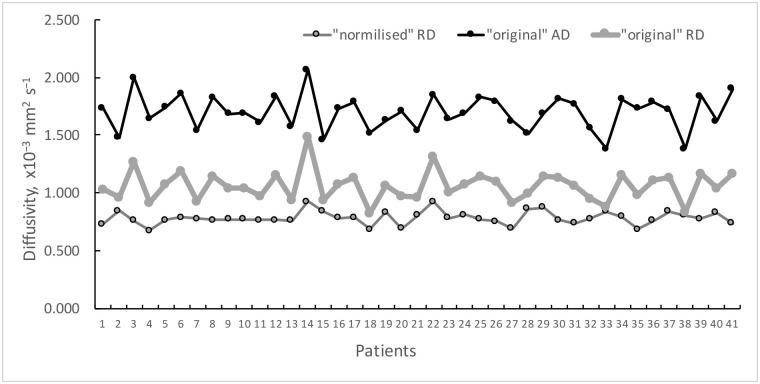
Individual values of observed (“original”) AD and RD diffusivities and “normalised” RD in OR MS lesions.